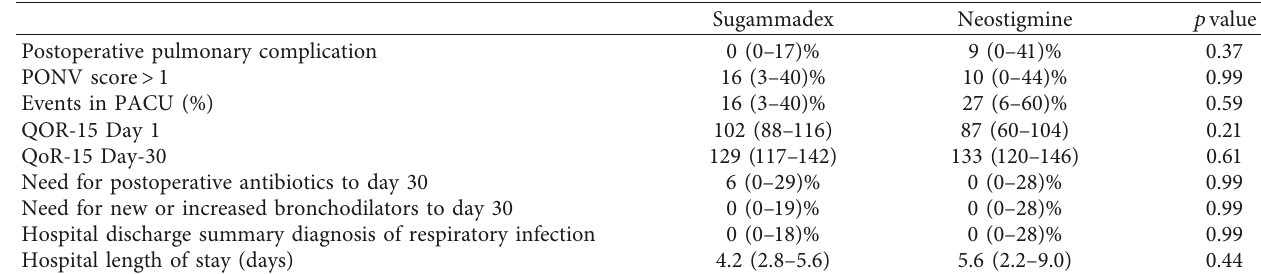
Table 3: Outcome